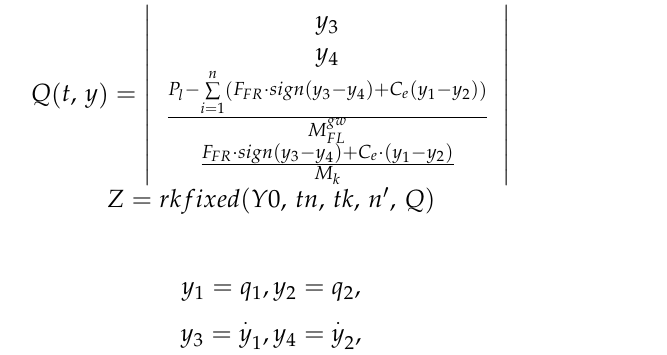
Figure 6. Design diagram of a flat car loaded with containers.